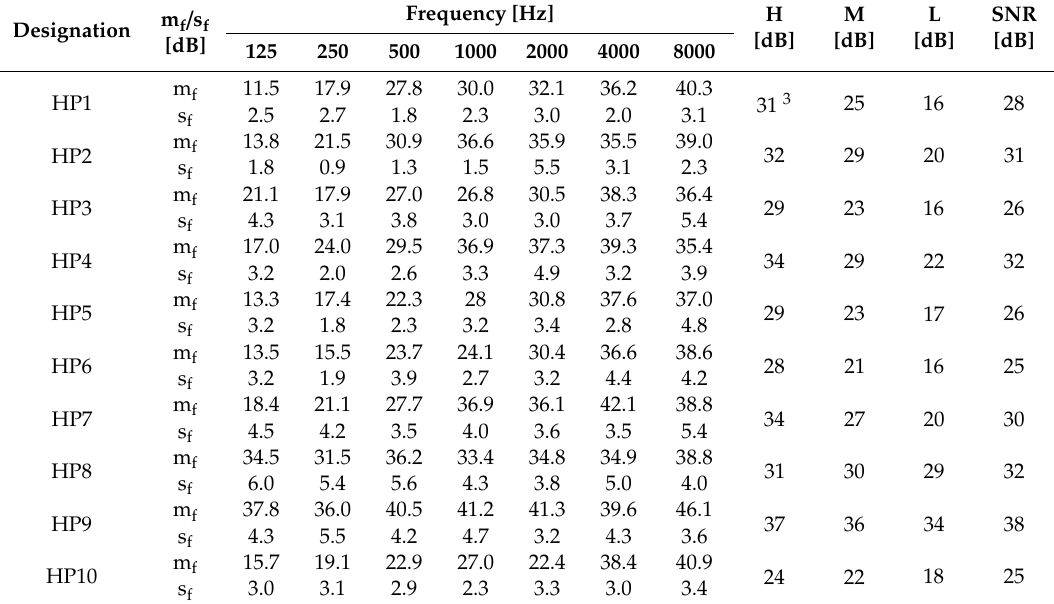
Table 1. Sound attenuation data of level-dependent hearing protectors. m f —mean attenuation 1 , s f —standard deviation, H—high-frequency attenuation value 2 , M—medium-frequency attenuation value, L—low-frequency attenuation value, SNR—single number rating, HP1 to HP10—hearing protectors 1 to